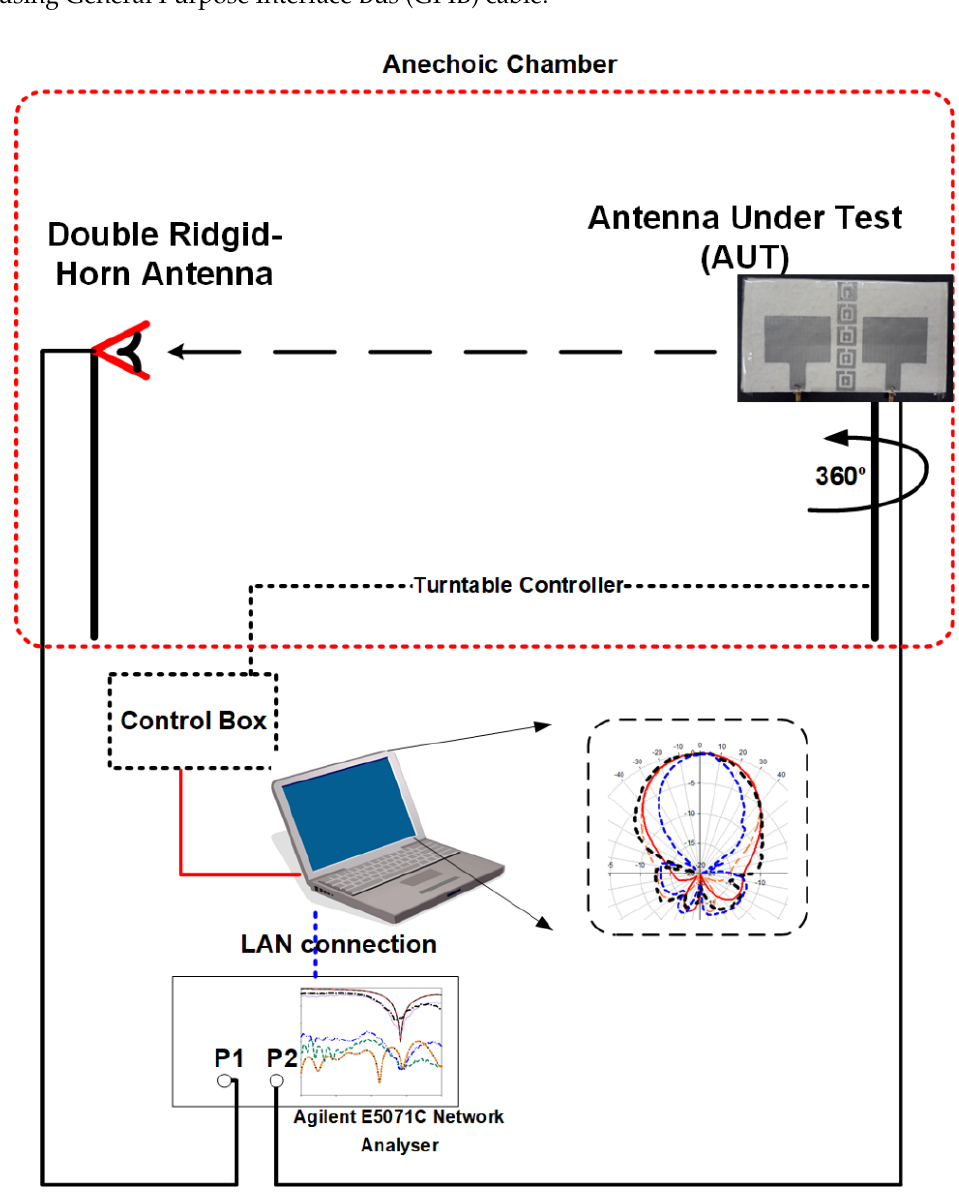
Figure 11. Experimental setup to measure the proposed antenna performance.